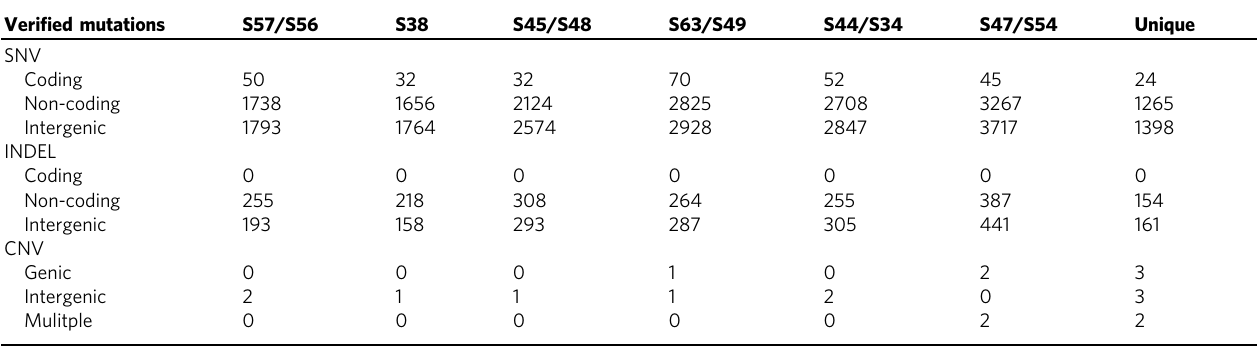
Table 1 Counts of veri fi ed events by